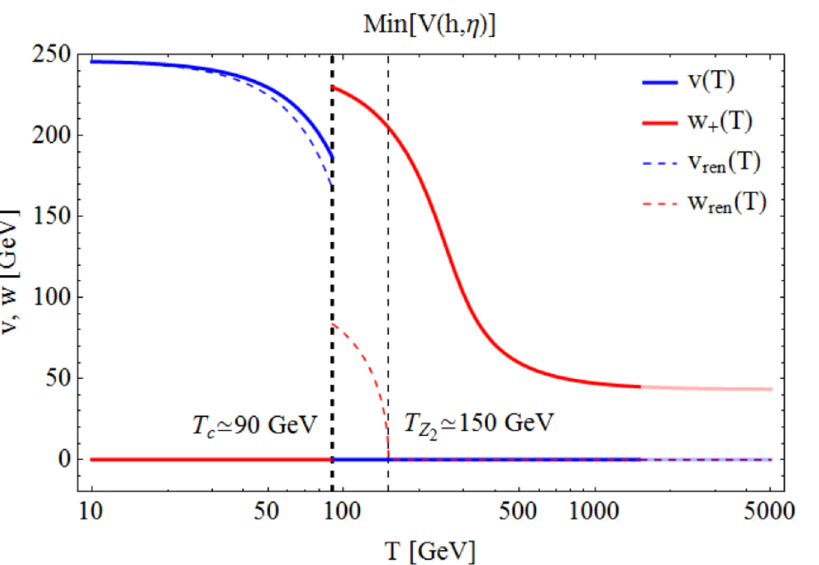
Figure 4 . Thermal evolution of the doublet and singlet vevs in our model for the benchmark point with λ η = − 0 . 15 , λ hη = 0 . 1 , m η = 75 GeV, and Λ = 1 . 5 TeV (solid lines), compared to the conventional case where higher-dimensional operators are neglected (dashed lines), assuming the same critical temperature T c ’ 90 GeV. The latter features the characteristic two-step breaking pattern, with Z 2 breaking at T Z > T c . The region where the validity of the considered EFT starts 2 to break down ( T > Λ ) is visualized by faint